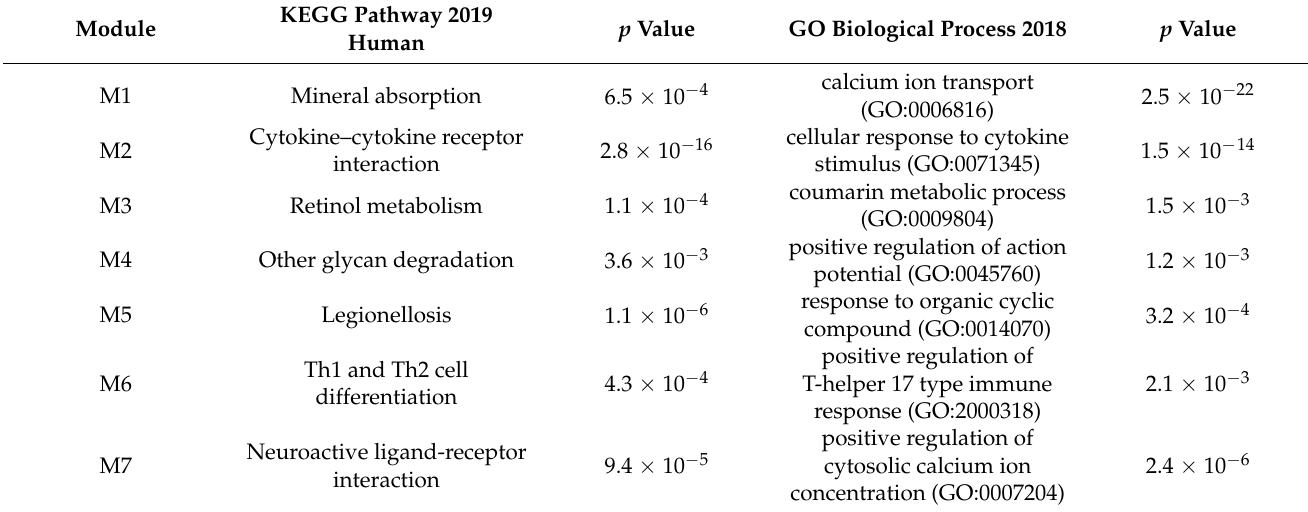
Figure 1. The structures of menthol and menthone, major components of Mentha essential oil ( A ). Protein–protein interaction network of Mentha essential oils (MEO) ( B ). The nodes and edges indicate the proteins and their relationships. Module extracted by Gene ontology enrichment analysis ( C ). The black nodes present seed nodes and the gray ones are nodes that interact with the seed nodes. Purple, Co-expression; Blue, Co-localization; Pink, Physical interactions; Yellow, shared protein domains; Orange, Predicted; Green, Genetic interactions; Sky, pathway. Table 1. Biological processes related to targets of MEO. Modules were assigned to biological processes using KEGG pathway 2019 human.